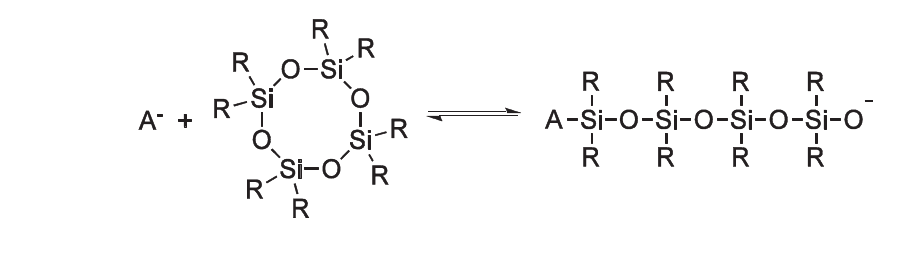
Figure 49. Equilibrium between rings and chains during the AROP of cyclic siloxanes (A − = ~Si(R) O − 2